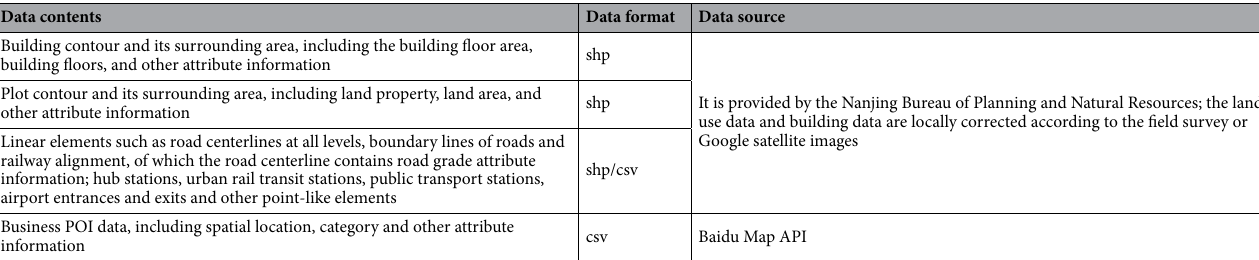
Table 6. Sources and basic information of built environment data. Source Author